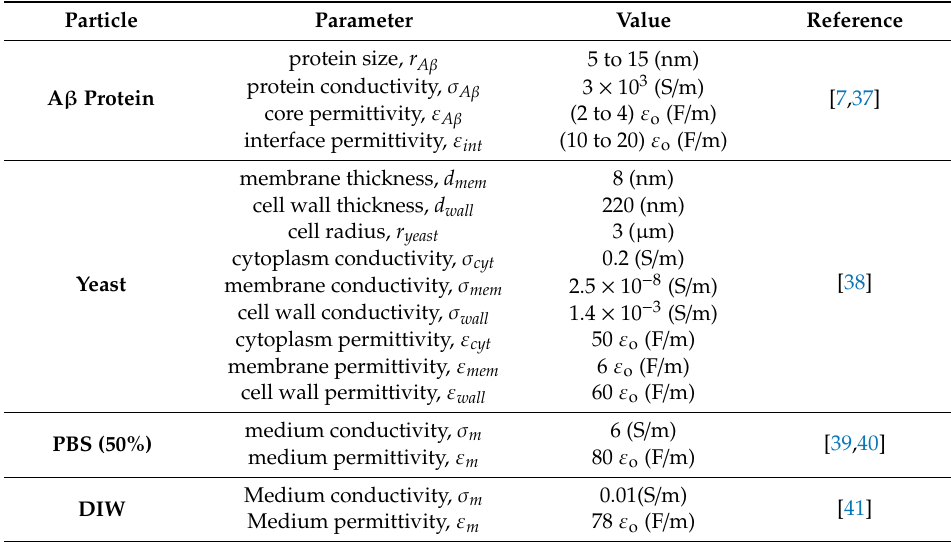
Figure 8. Re[ f CM ] of amyloid-beta protein and yeast cells in phosphate bu ff ered saline (PBS) (50%). Figure 8. Re [ f CM ] of amyloid-beta protein and yeast cells in phosphate buffered saline (PBS) (50%). Table 2. Parameters for the Clausius–Mossoti Factor